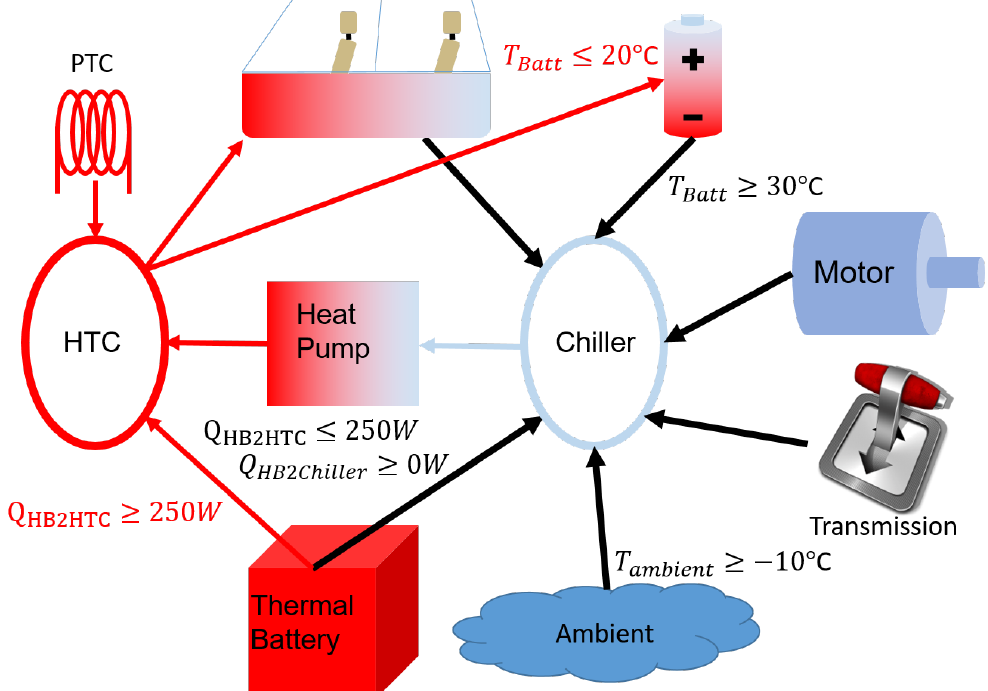
Figure 2. Schematic of thermal contributors to the heat pump, where HTC is the high temperature coolant circuit used for battery and cabin